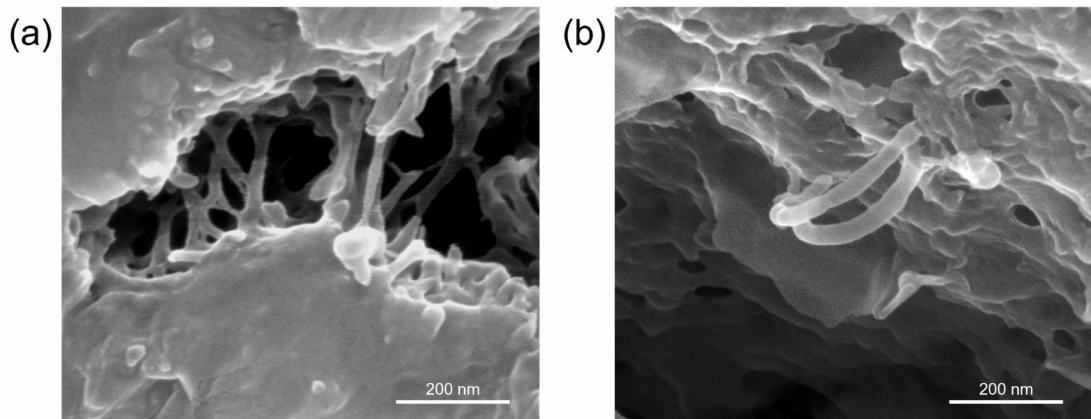
Figure 13. ( a , b ) SEM images of the crack bridging e ff ect of TNTs in ordinary Portland cement paste at di ff erent locations of the fractured